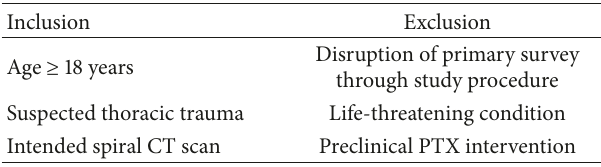
Table 2: Inclusion and exclusion